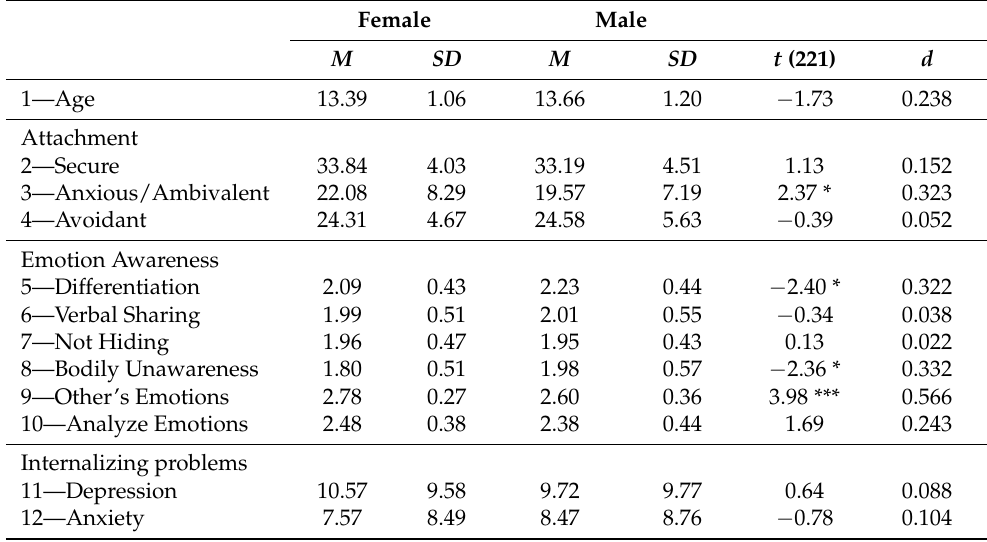
Table 2. Descriptive statistics and gender differences for age, attachment patterns, emotion awareness dimensions, and internalizing problems ( n = 223).